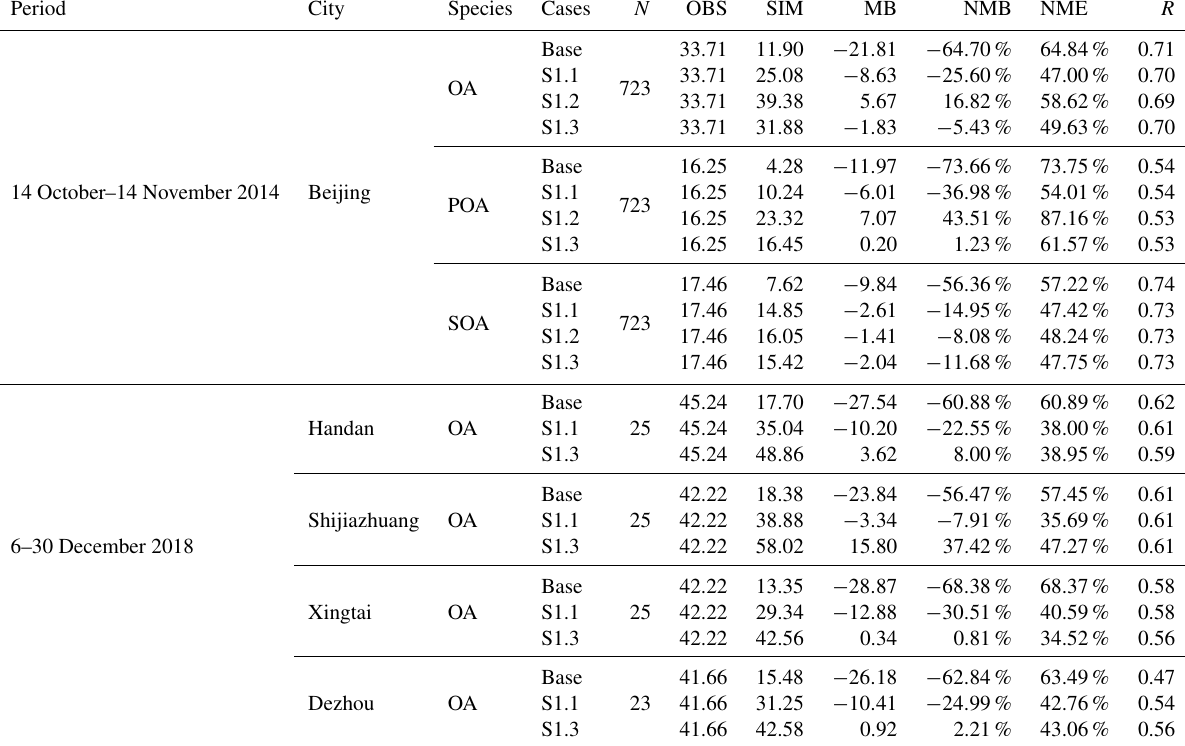
Table 5. Model evaluation statistics for hourly OA, POA, and SOA concentrations during 14 October–14 November 2014, and daily OA concentrations during 6–30 December 2018, for different sensitivity simulation